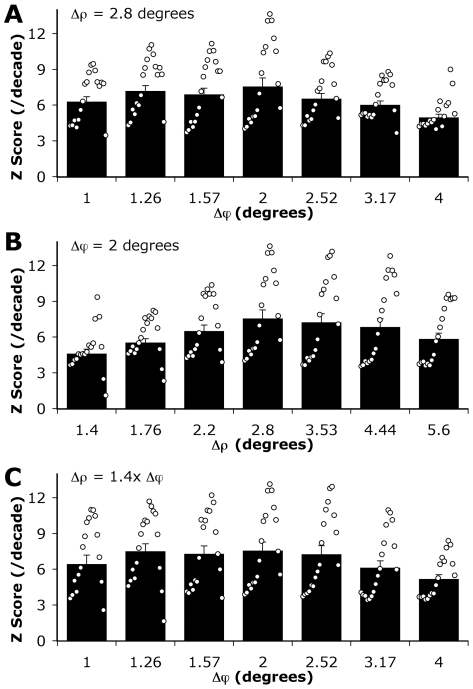
Effect of image blur and spatial sampling on velocity discrimination.A) the optical blur (Δρ) was a constant 2D Gaussian of 2.8 degrees (full width at half maximum) and the spatial sampling rate (Δϕ) was varied. B) The spatial sampling was set to 2 degrees (180 pixels in horizontal dimension) and the optical blur varied. C) The optical blur was fixed at 1.4 times larger than the spatial sampling rate, which was varied. The circles show, in order, the Z score between each of the 19 tested speeds between 0.1 and 100degrees/s inclusive (equally spaced on a log scale, i.e. 18 intervals). The columns and error bars show mean Z scores and standard errors of the mean respectively. In each case it was found that the maximal Z score (i.e. best discrimination between velocities) was with a spatial sampling of 2 degrees and an optical blur of 2.8 degrees.